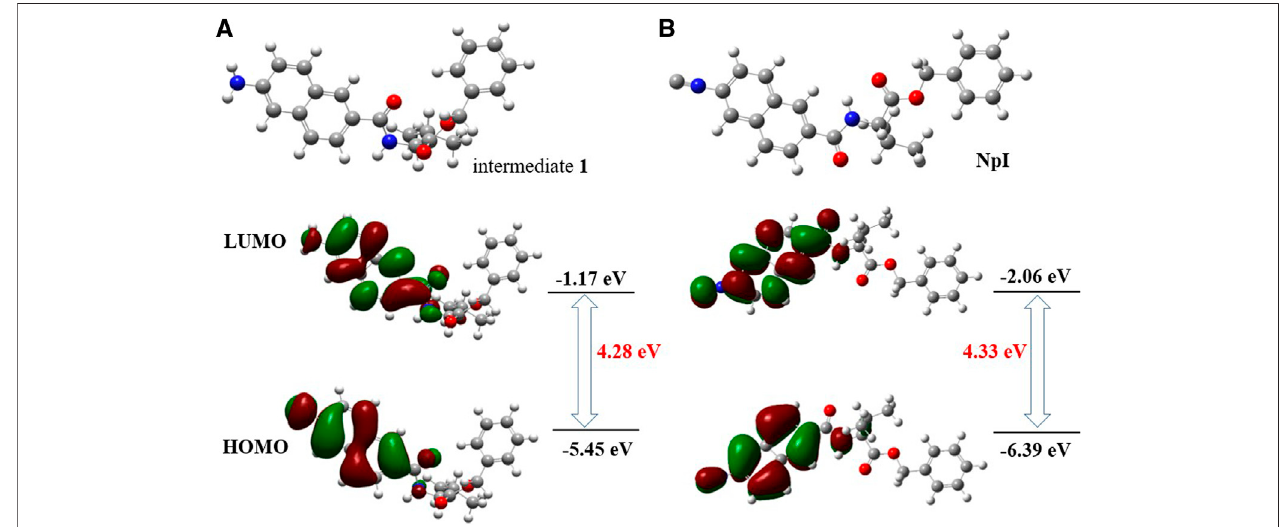
FIGURE 6 | Calculated DFT energy and frontier molecular orbital diagrams of (A) precursor 1 and (B) NpI.